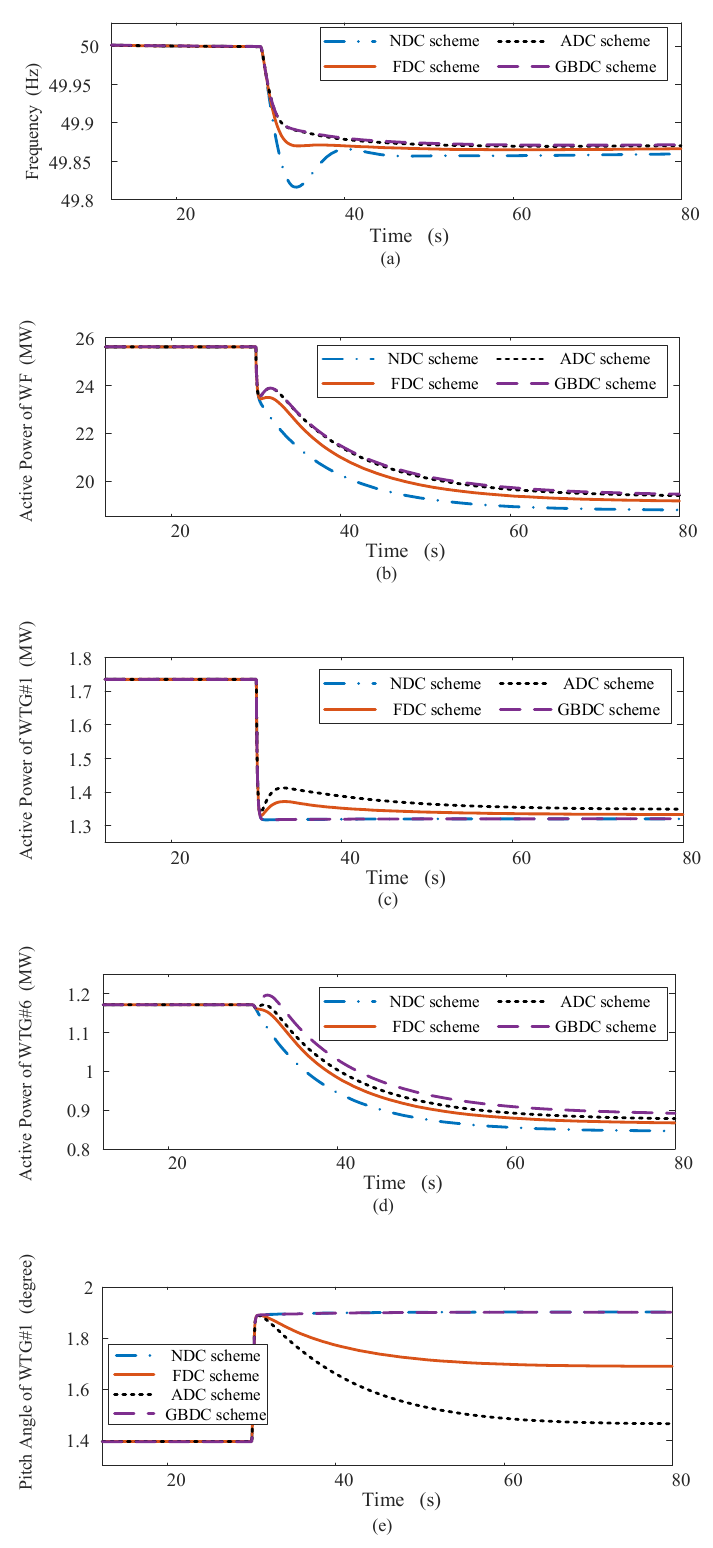
Figure 13. Simulation results of Case 3: ( a ) system frequency; ( b ) active power of WF; ( c ) active power of WTG#1; ( d ) active power of WTG#6; ( e ) pitch angle of WTG#1. β , varies with the wind speed, the pitch angle of the As the deloading pitch angle, 0 WF increases to a new value at 30s t = . After that, the pitch angle of the FDC and the